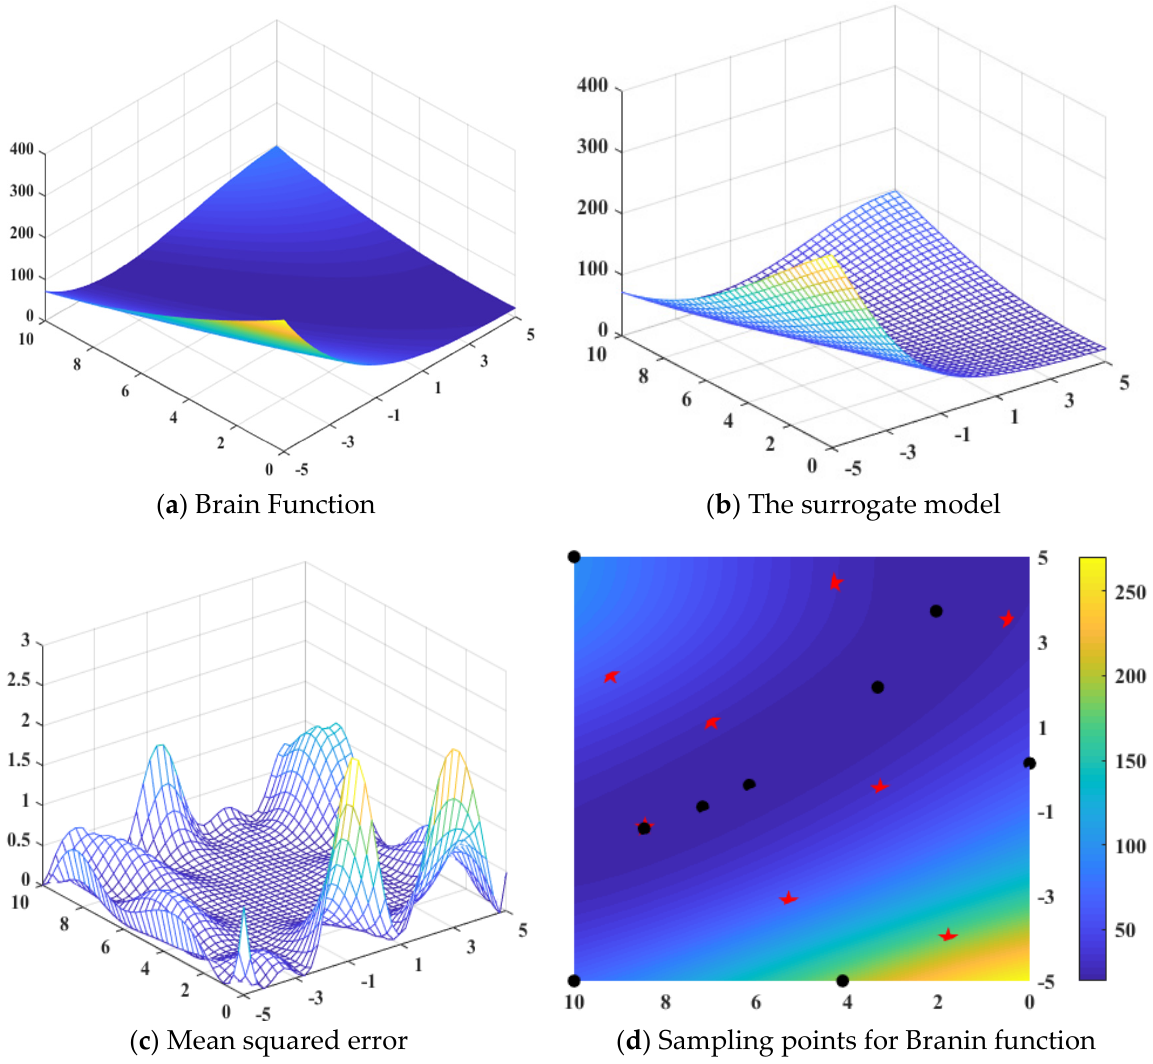
Figure 3. Information of the test result on the surrogate model for Branin Function.